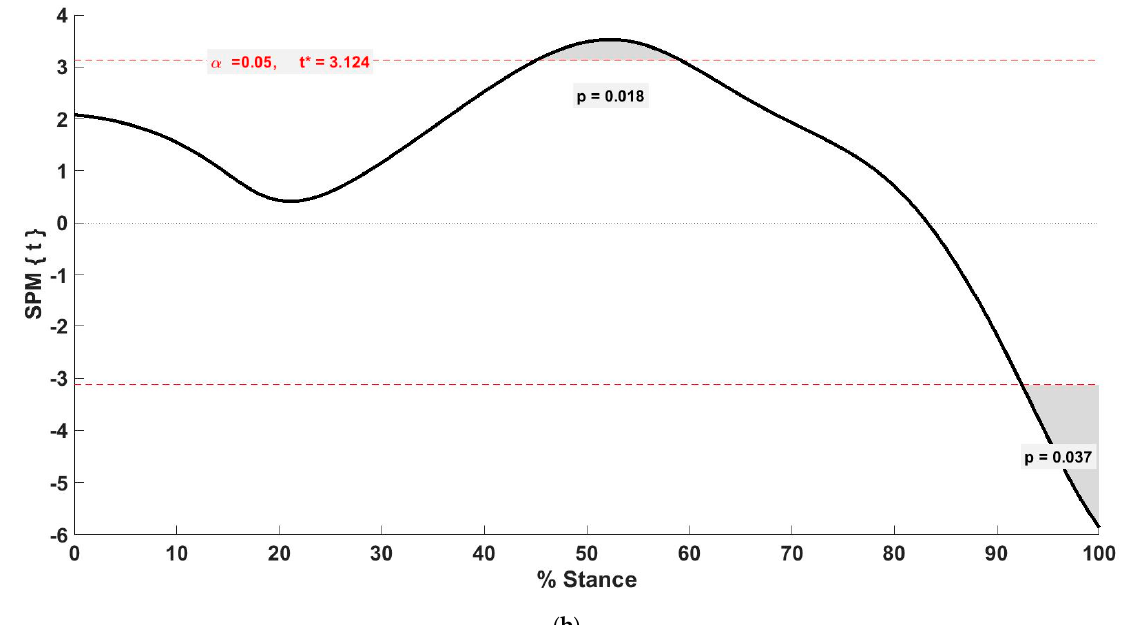
Figure 1. ( a ) Mean (solid line) and standard deviation (shaded) of the sagittal plane rearfoot angle between preferred (black), +5% (red), and +10% (blue) step rate conditions. ( b ) t -values of SPM post hoc comparison between preferred and +10% conditions for sagittal plane rearfoot angle. Dashed red lines indicate critical threshold ( α = 0.05). Gray shaded area indicates regions with statistically significant differences between the preferred and +10% condition.